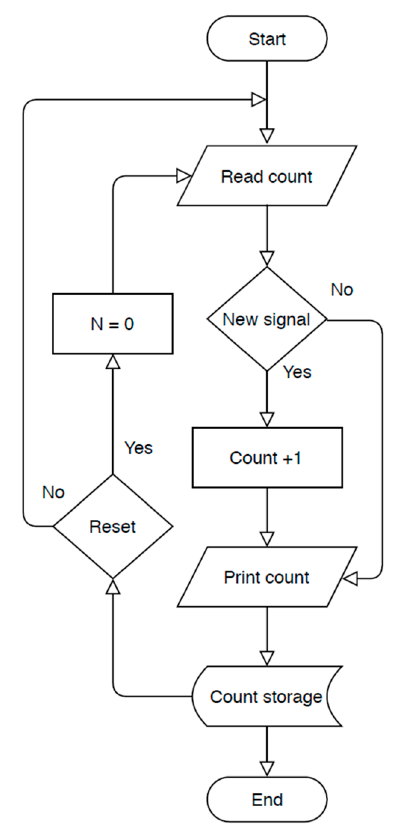
Figure 5. Counter flowchart to count the signal numbers.